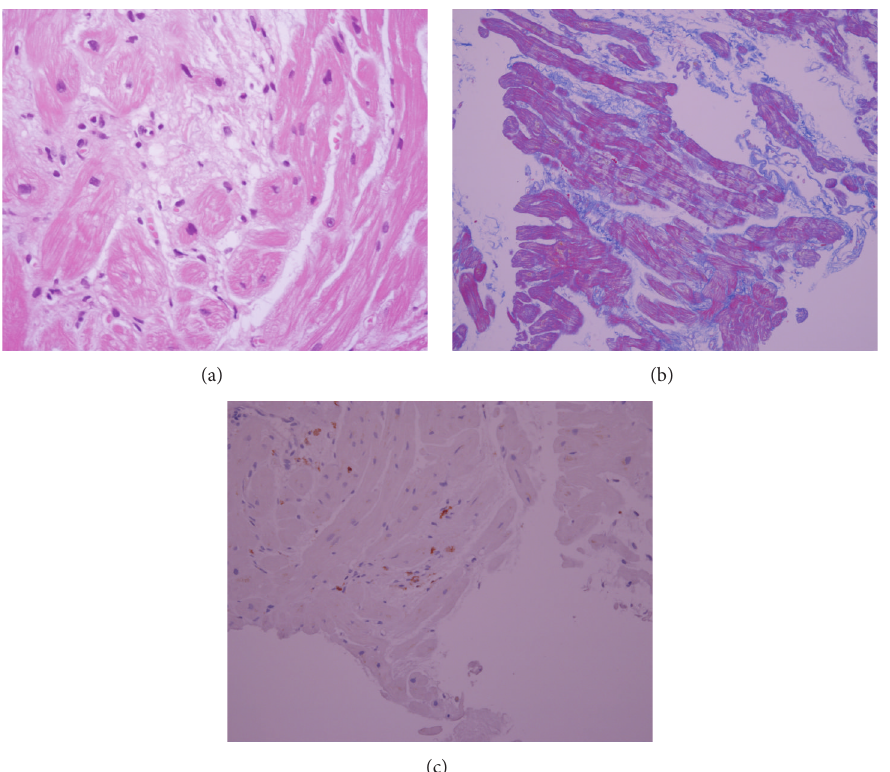
Figure 1: Myocardial biopsy histopathology. (a) Grade 2 colliquative myocytolysis and perinuclear disappearance of myofibrils with intramyocardial edema appearing as an empty sarcolemmal tube. Hematoxylin-eosin stain, × 400. (b) Interstitial fibrosis is evident. Azan staining, × 200. (c) Mild cell infiltration in the myocardium. Immunostaining for CD 45 antigens; hematoxylin-eosin stain, ×